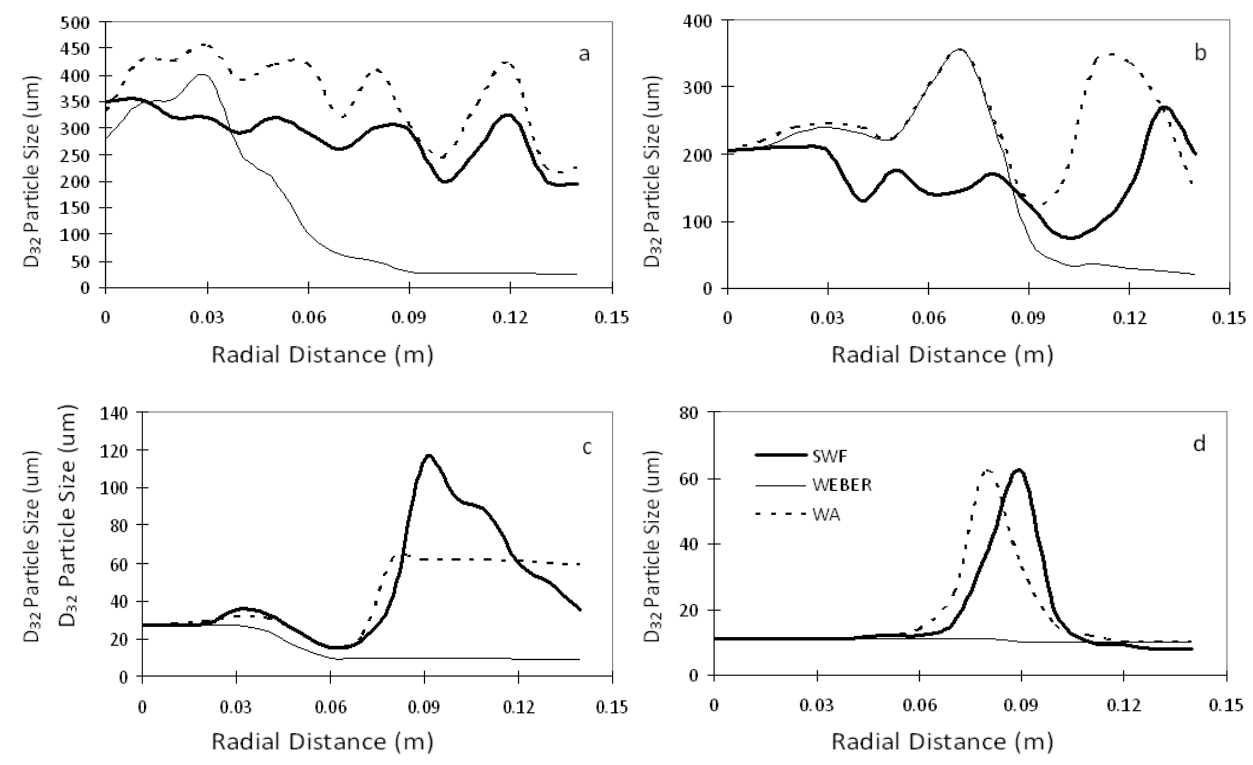
Figure 3. Predicted radial variation of the D ( b ) 100 psi (0.69 MPa); ( c ) 200 psi (1.38 mpa); ( d ) 300 psi (2.07